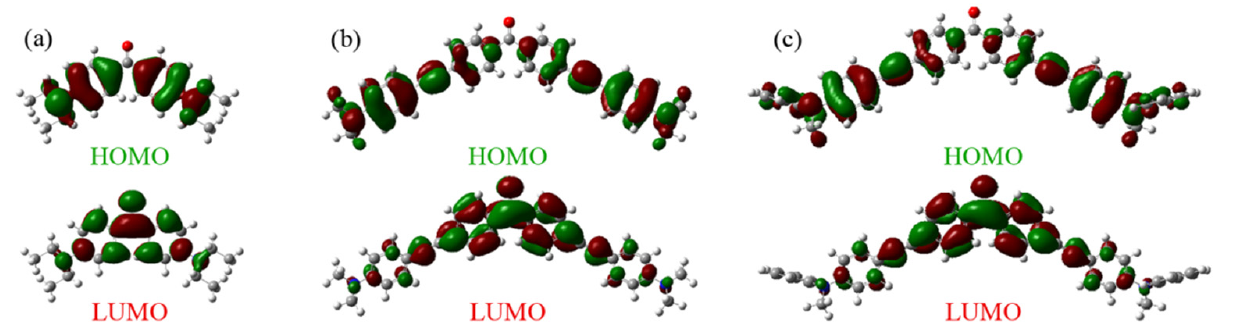
Figure 2. Frontier orbital diagrams of molecules with different degrees of conjugation. HOMO: Highest Occupied Molecular Orbital; LUMO: Lowest Unoccupied Molecular Orbital. ( a ) BD-PM; ( b ) BD-PPM; ( c ) BM-PPPM.